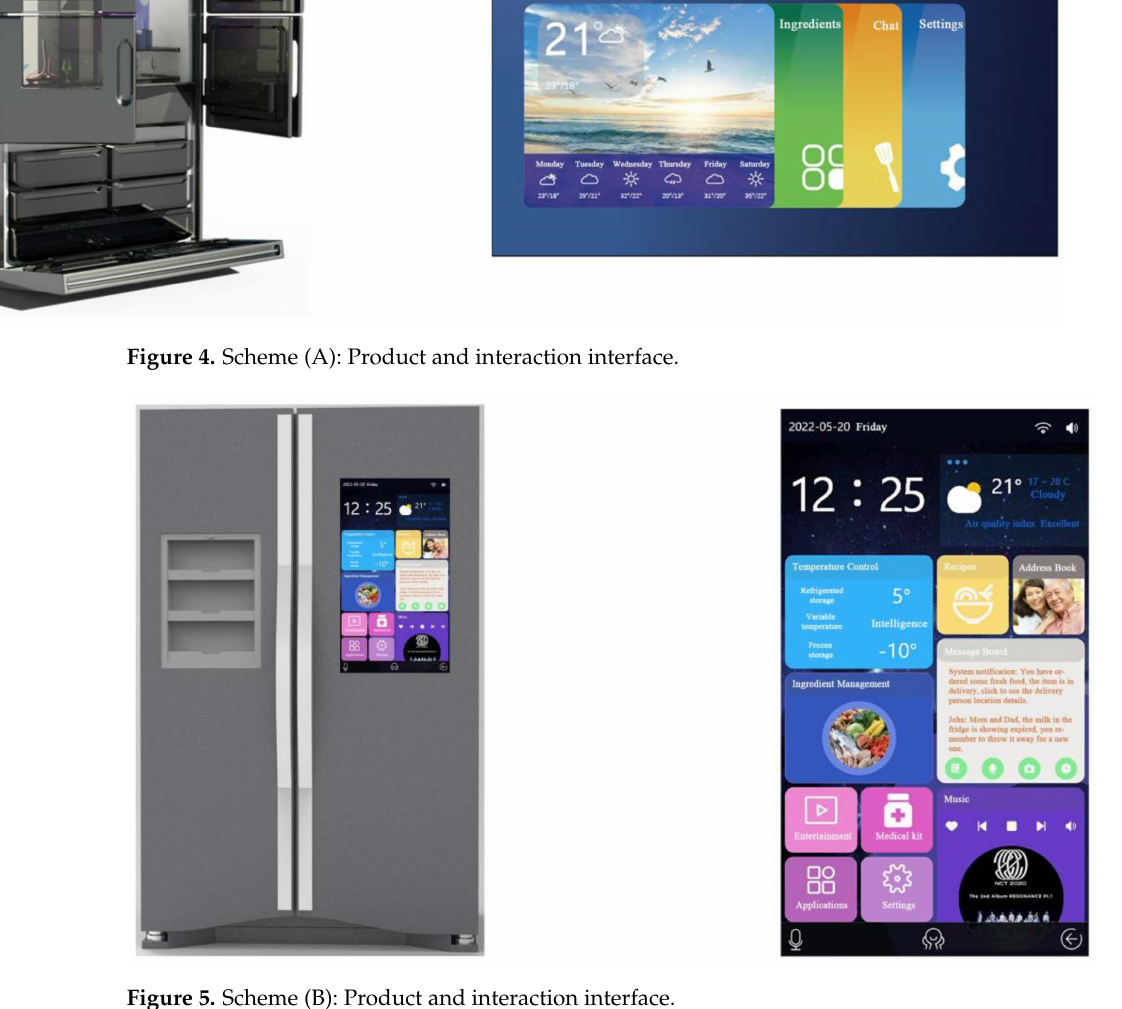
Figure 5. Scheme (B): Product and interaction